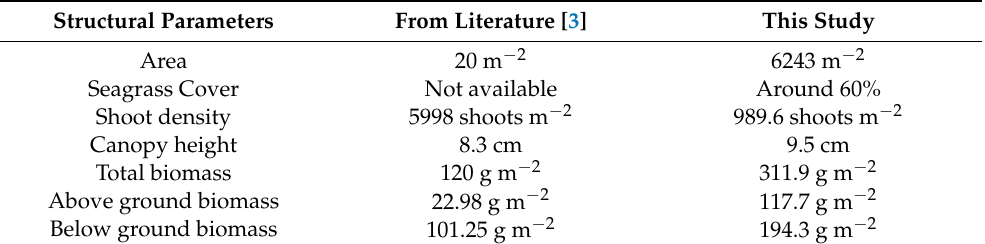
Table 5. Summary of H. wrightii morphometrics in Gamboa Bay, Cabo Verde from previous publica- tion [4] and this